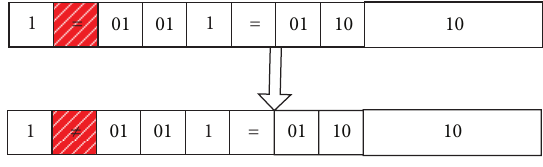
Figure 7: An example for operator mutation.